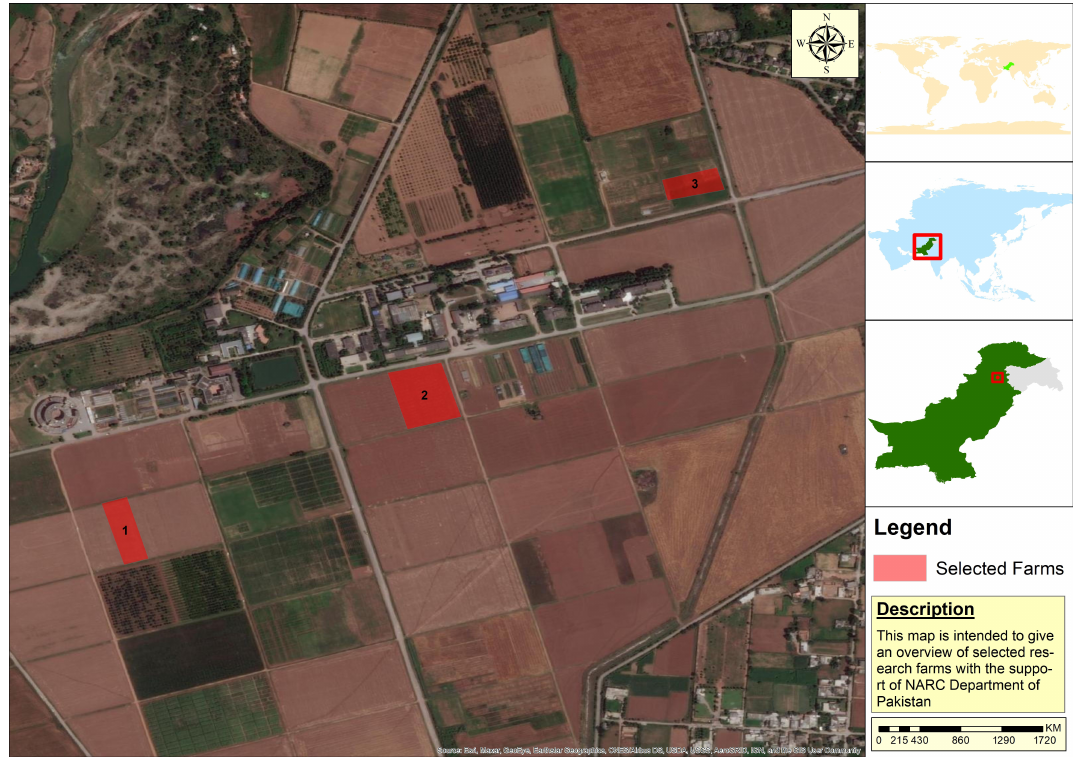
Figure 2. Study area